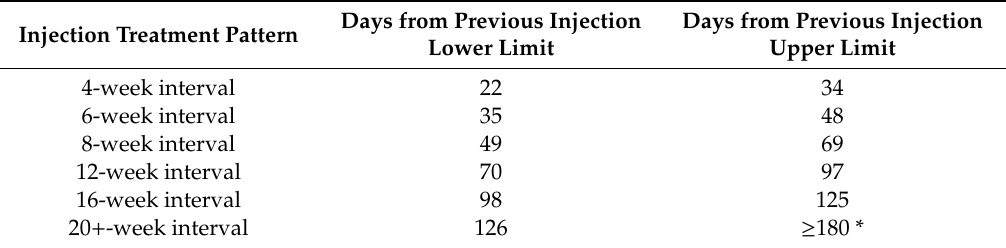
Table 1. Treatment interval